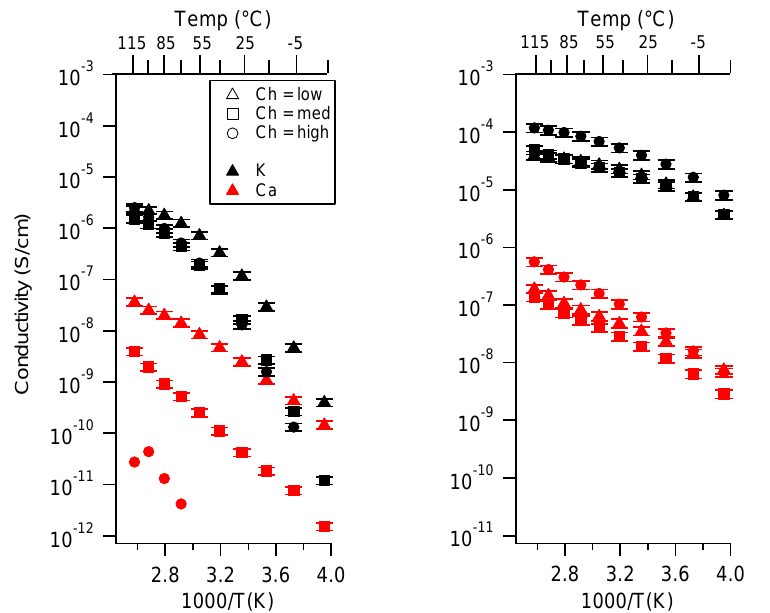
Figure 4. Conductivity as a function of charge density for PEGDMA1000_Ch_SSM (left) and PTHFDA1000_Ch_STFSIM (right) SIPEs swelled with DEG. Temperatures ranged from − 20 °C to 115 °C.